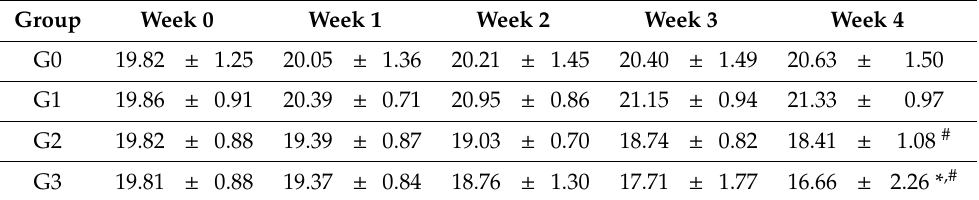
Table 1. Body weight changes in the week 4 necropsy group administered with TDF for four consecutive weeks.